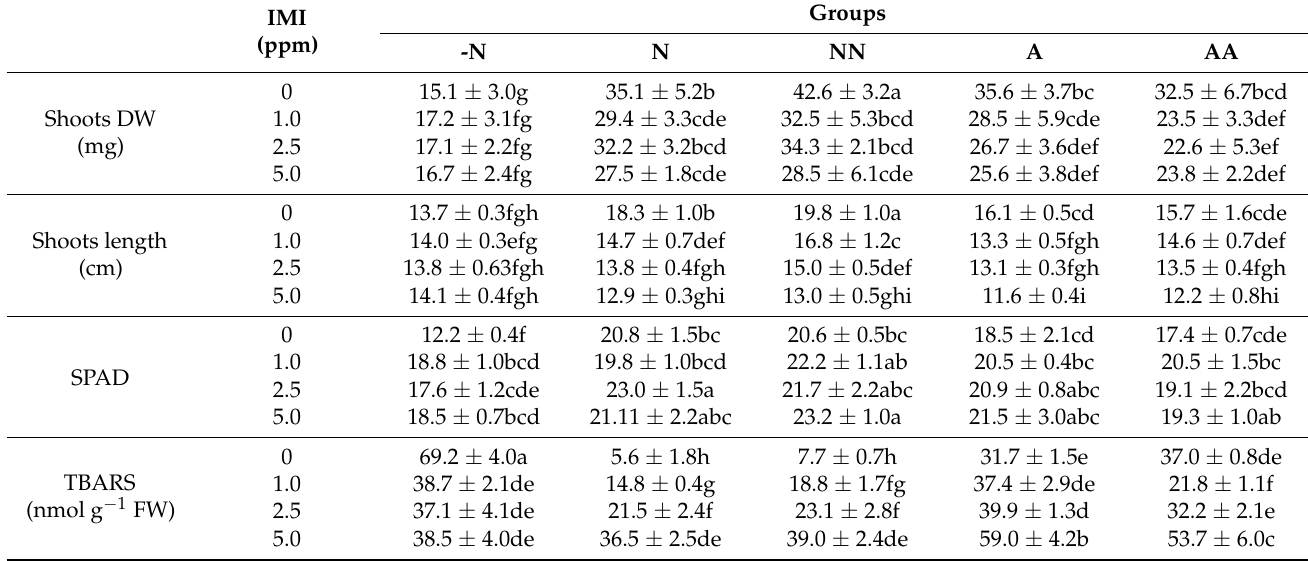
Table 1. Effect of IMI on shoot dry weight (DW), shoot length, SPAD value and thiobarbituric acid-reactive substance (TBARS) in maize subjected to different nitrogen treatments when exposed to